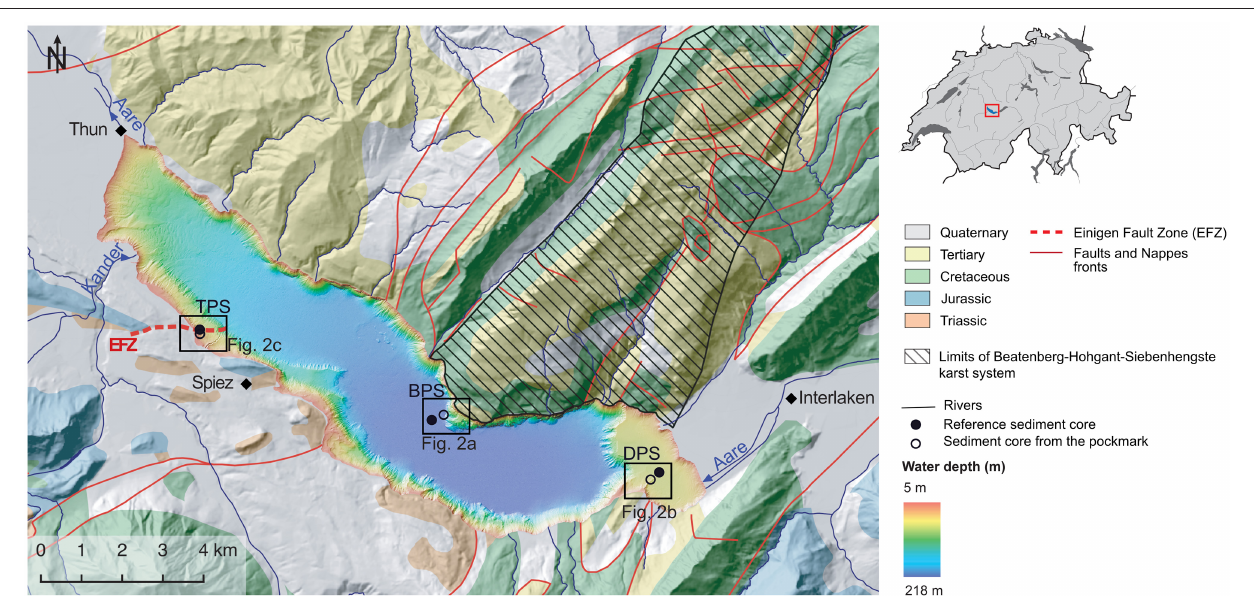
FIGURE 1 | Bathymetric map of Lake Thun, Switzerland. Also indicated is the geology of the area [Swisstopo (2014) Vector dataset], the area of the Beatenberg-Hohgant-Siebenhengste karst system (Géotope Suisse n ◦ 127), the location of the Einigen Fault Zone (EFZ; Fabbri et al., 2017), and the different sampling sites, Beatenberg (BPS; a), Daerligen (DPS; b), and Tannmoos (TPS; c). The sampling positions at the reference and pockmark sites are represented by the black circles and dots, respectively.